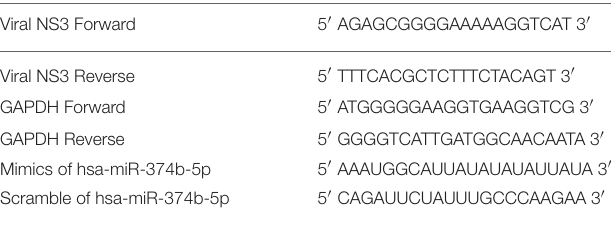
TABLE 1 | List of primers, microRNA oligos, and scramble